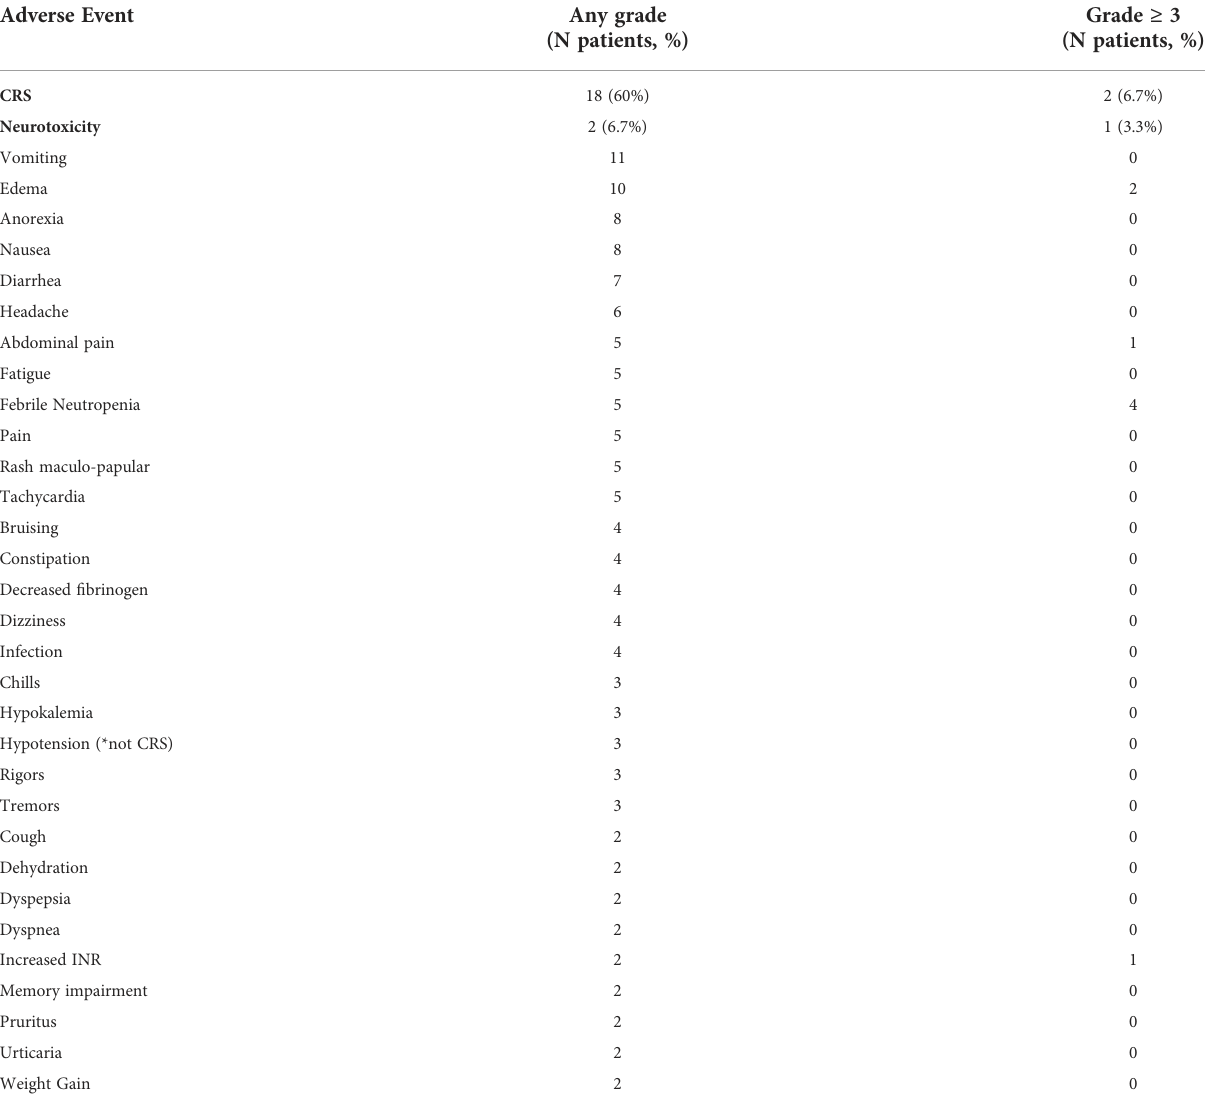
TABLE 3 Adverse Event Data to 30 days after CLIC-1901 Infusion. Adverse Event Any grade